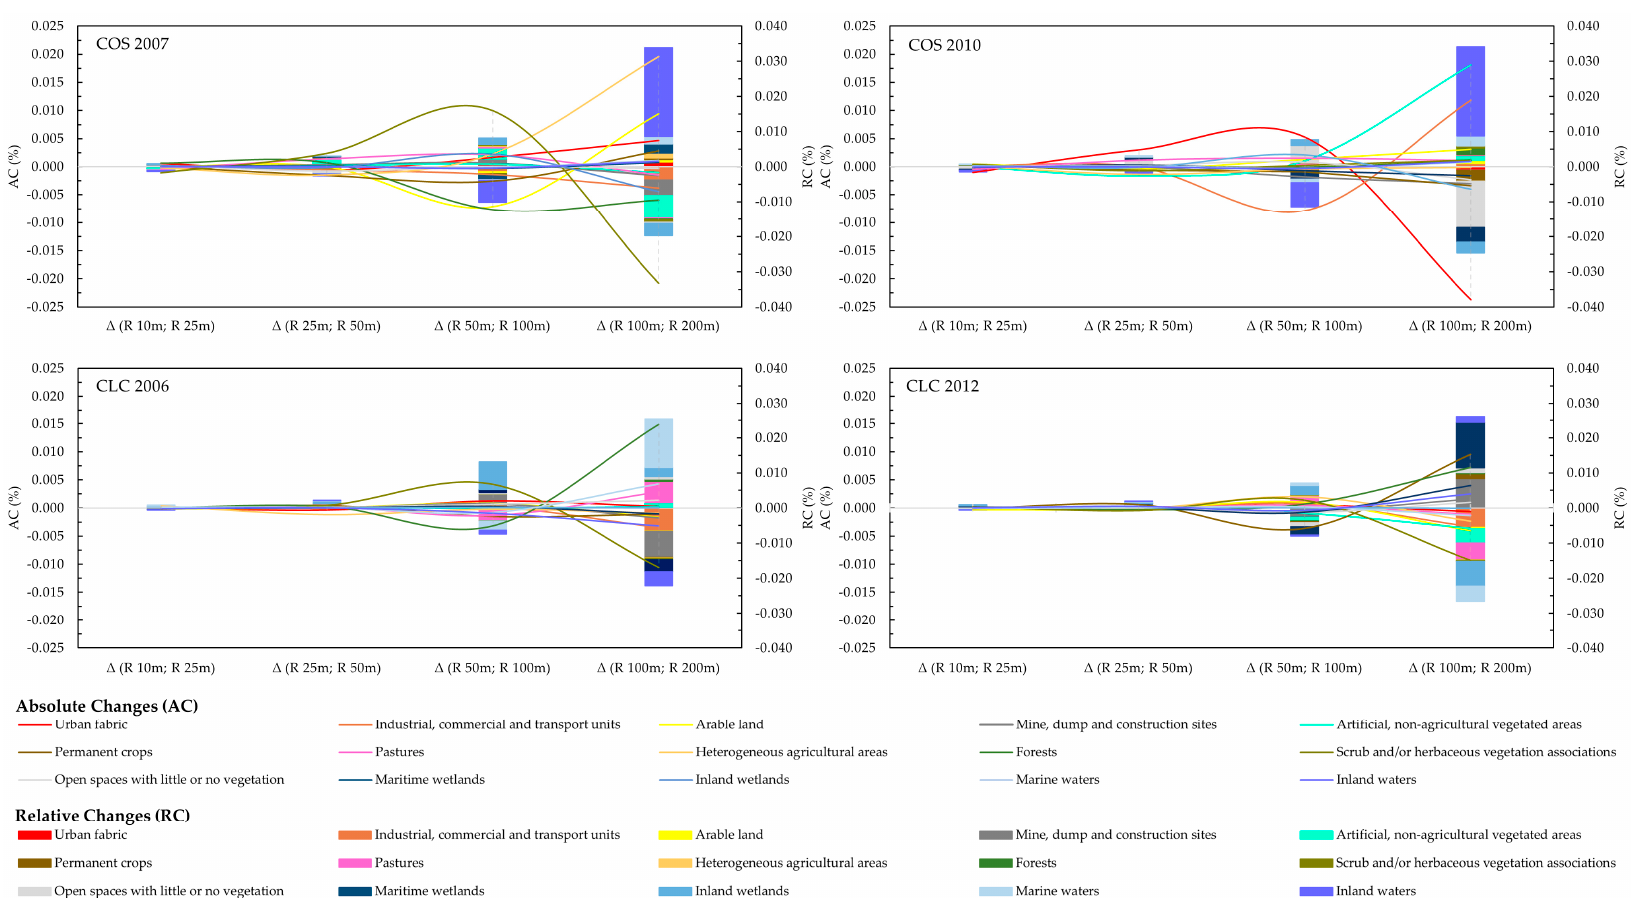
Figure 5. Absolute and relative change variation (% area) between LUC geoinformation with different resolutions (R, raster resolution in meters).